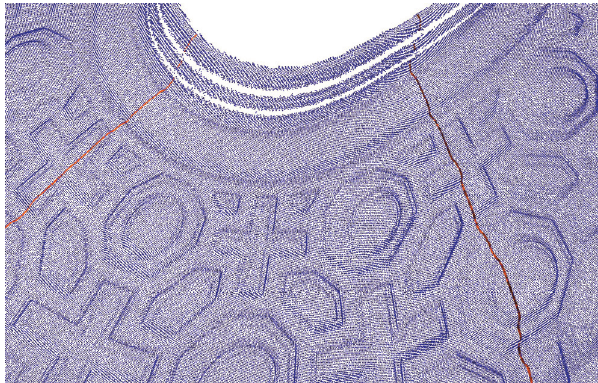
Figure 6. Portion of range based model (point cloud and sub selection of